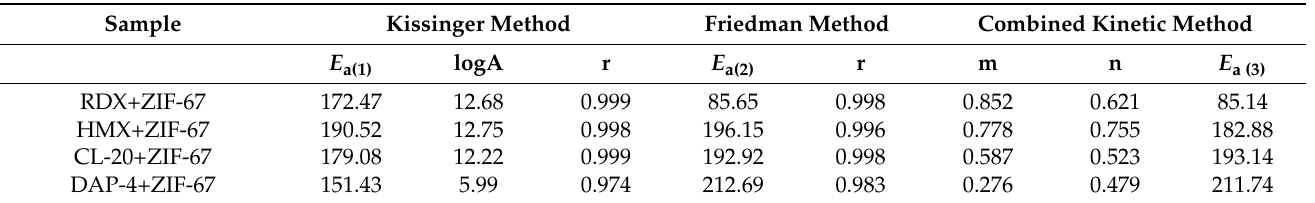
Table 1. Kinetic parameters calculated by Kissinger, Friedman isoconversional and combined kinetic